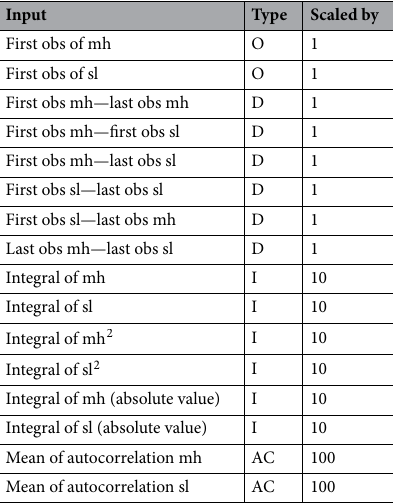
Table 1. We include 16 summary statistics—gathered from the individual mappings of mental health (mh) and stressor load (sl) to the latent space (see Fig. 1c)—as inputs to the ODEnet. We additionally scale them according to their range and type (Observation, Difference, Integral, and AutoCorrelation) for achieving numerically similar